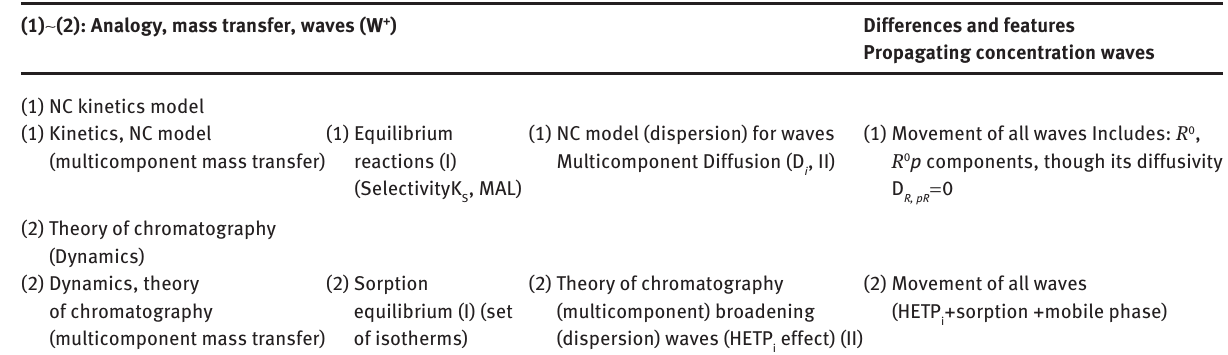
Table 1 Analogies between NC kinetics and theory of chromatography (see Conclusion Section